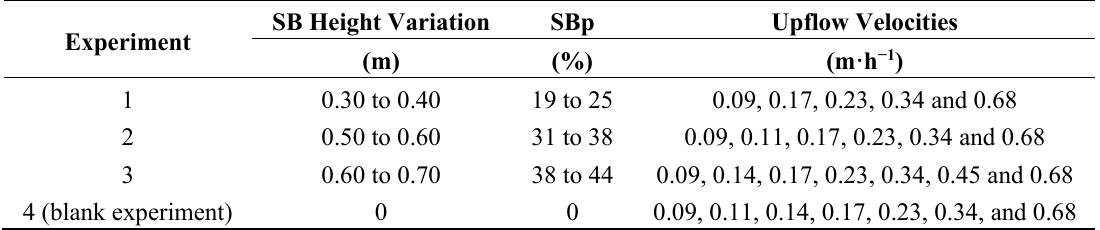
Table 2. Setup of experiments in lab-scale UASB reactors to test the sludge filtration capacity to remove helminth